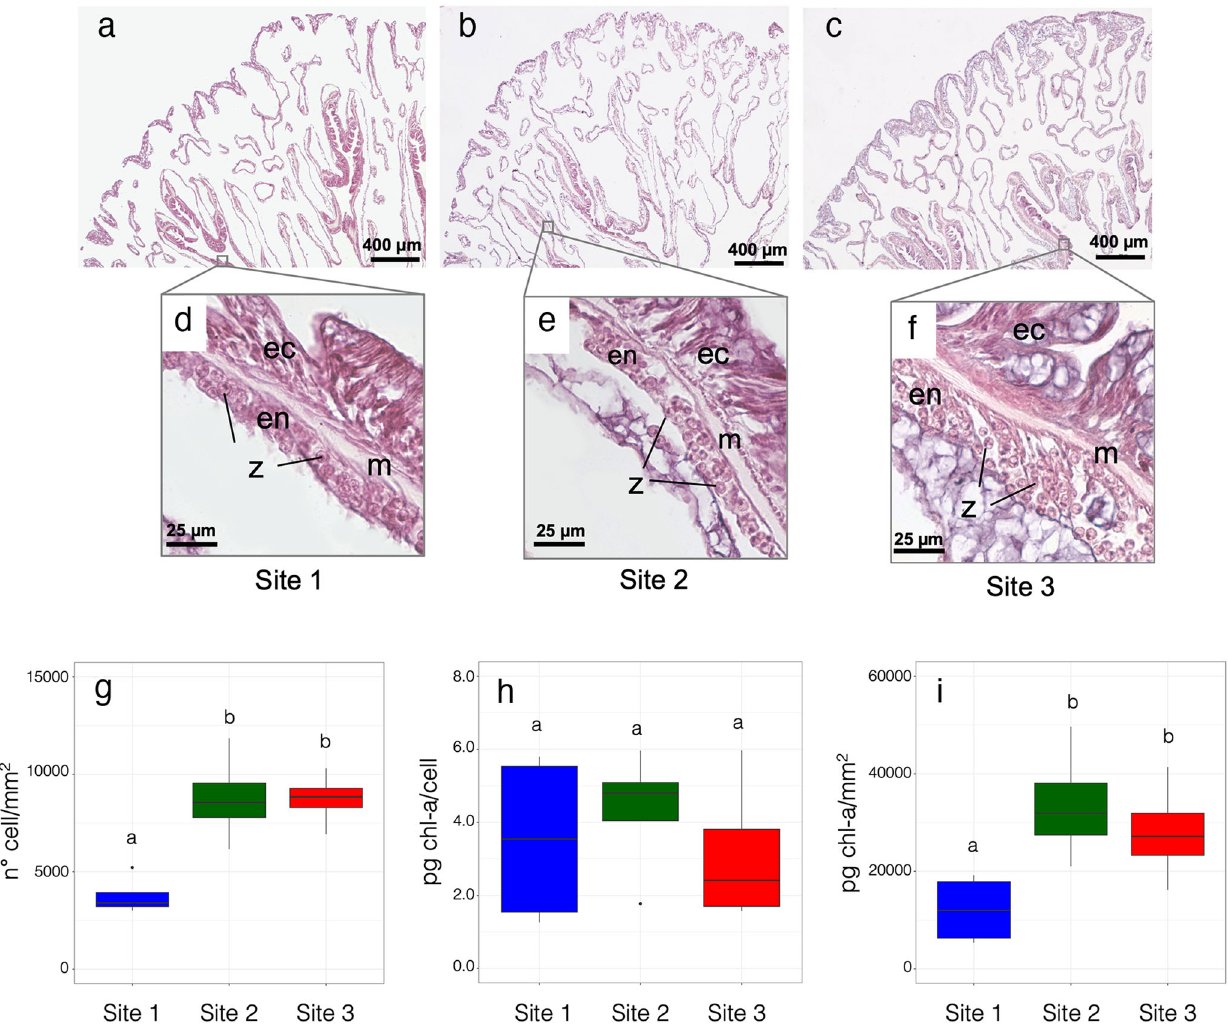
Fig. 3 Symbiont cells in B. europaea polyps sampled along the Panarea pH gradient. a – c Histological transverse sections of representative polyps in Sites 1-3 (x 4 magni fi cation). d – f Symbiont cells within the endoderm of the mesentery highlighted by x40 magni fi cation. z: zooxanthellae; ec: ectoderm; m: mesoglea; en: endoderm. g Symbiont cell density and h chlorophyll-a (chl-a) concentration normalized over cell count or i polyp area. The boxes indicate the 25 th and 75 th percentiles and the line within the boxes mark the medians. Whisker length is equal to 1.5 × interquartile range (IQR). Circles represent outliers. Different letters indicate statistical differences ( p < 0.05; number of corals = 4 per